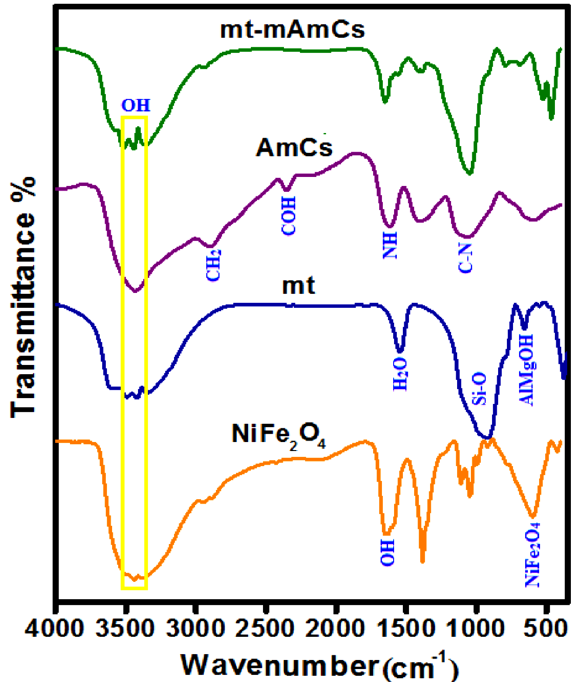
Figure 1. FTIR of NiFe 2 O 4 , MMT, AmCs and MMT-mAmCs